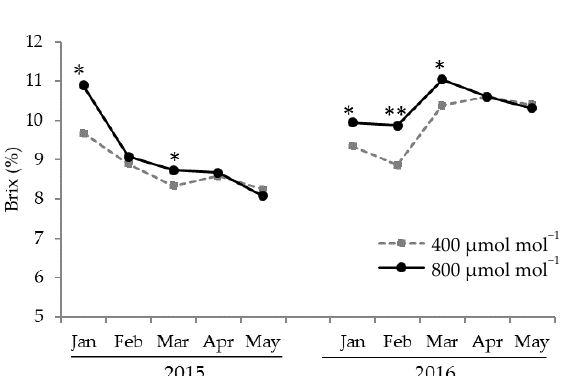
Figure 4. Effect of different concentrations of CO 2 enrichment on the growth of strawberry Figure 5. Effects of different concentrations of CO 2 enrichment on the fruit Brix of strawberry CO 2 concentration was controlled that 400 µ mol mol − 1 treatment was kept more than 400 µ mol mol − 1 in all day ‘Sagahonoka’ ( ( a ): Plant height, ( b ): Leaf length × Leaf width). CO 2 concentration was controlled that ‘Sagahonoka’. CO 2 concentration was controlled that 400 µmol mol −1 treatment was kept more than and 800 µ mol mol − 1 treatment was kept more than 800 µ mol mol − 1 and 400 µ mol mol − 1 during no ventilation 400 µmol mol −1 treatment was kept more than 400 µmol mol −1 in all day and 800 µmol mol −1 treat- 400 µmol mol −1 in all day and 800 µmol mol −1 treatment was kept more than 800 µmol mol −1 and 400 and ventilation, respectively. **and * are significantly different at 1% and 5% levels, respectively, by two-way ment was kept more than 800 µmol mol −1 and 400 µmol mol −1 during no ventilation and ventilation, µmol mol −1 during no ventilation and ventilation, respectively. * and ** are significantly different at ANOVA, and ns is not significantly different. respectively. * Is significantly different at 5% levels, respectively, by t -test. 5% and 1% levels, respectively, by t -test.